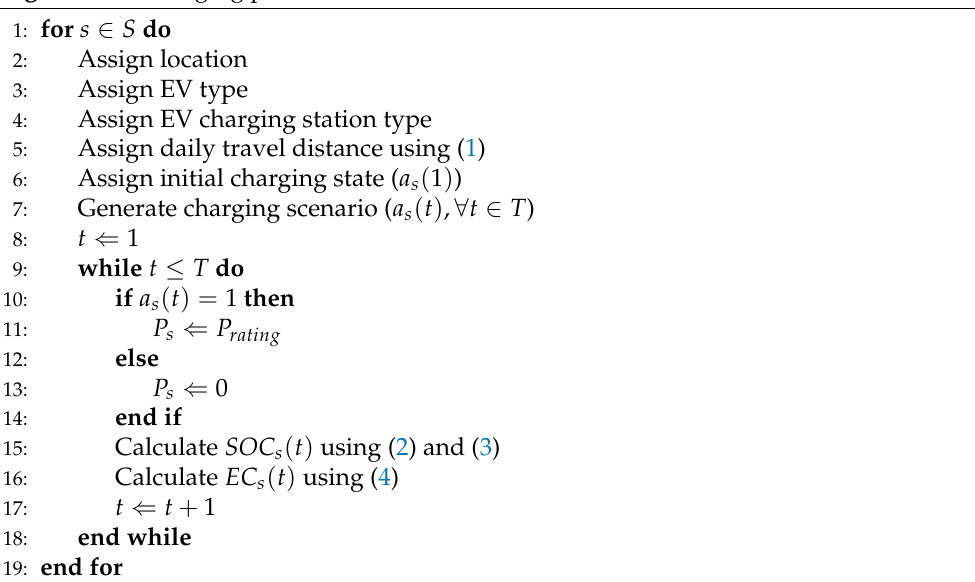
Figure 7. Charging schedule simulation flowchart. Algorithm 1 Charging pattern